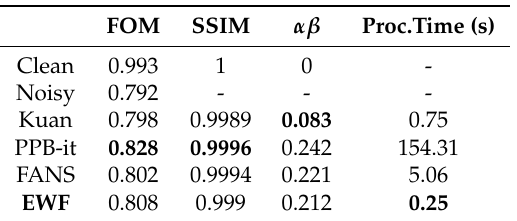
Table 1. Measures for squares.